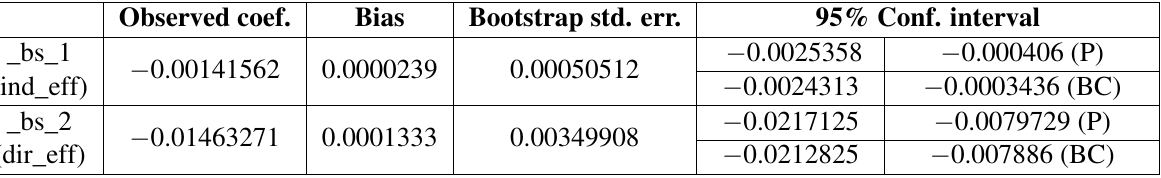
Table 5 Bootstrap method was used to test the mediation effect of debt concentration.